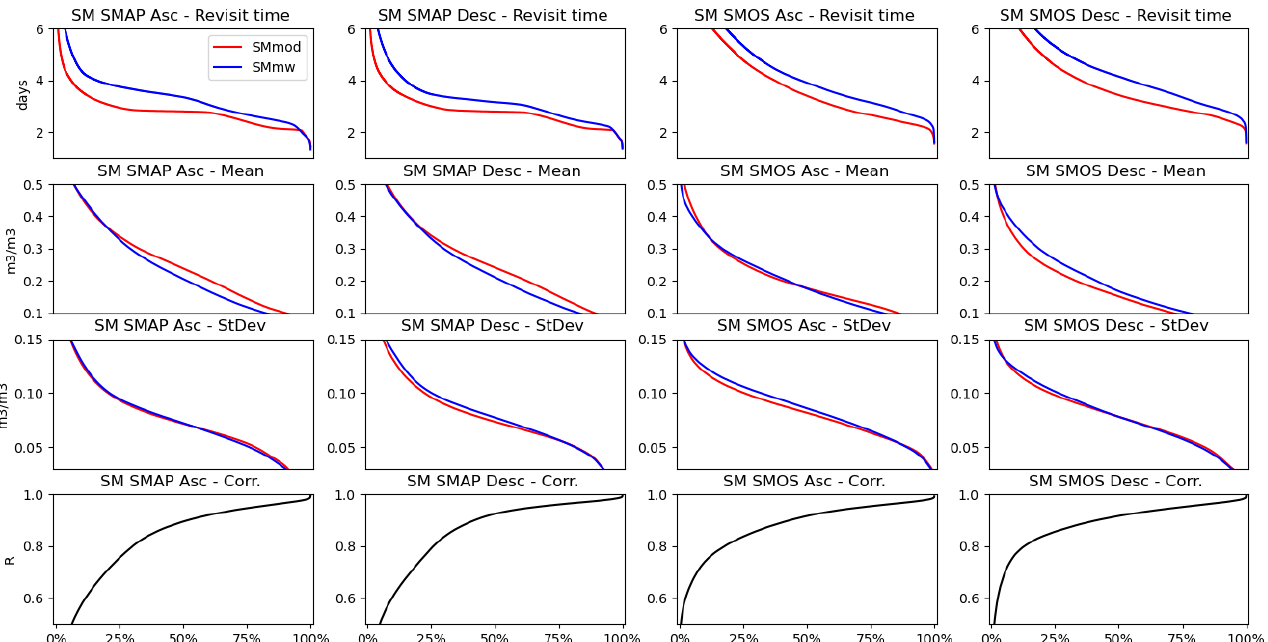
Figure 3. Cumulative plots of global SMAP Asc, SMAP Desc, SMOS Asc, and SMOS Desc SM mw and SM mod retrievals for the coverage, bias, standard deviation, and intercorrelation (corr.).